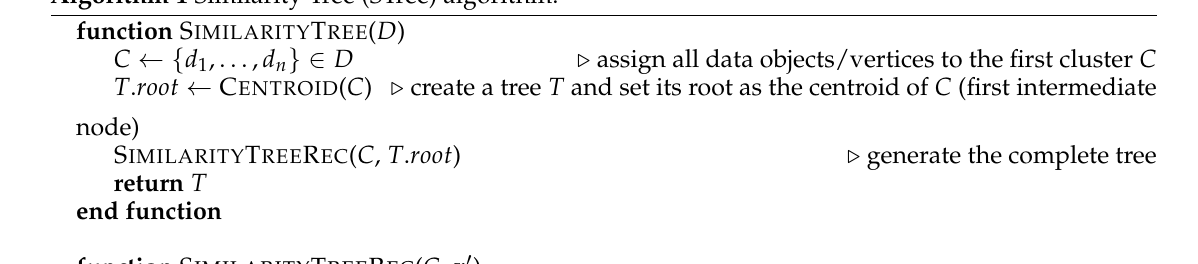
Algorithm 1 Similarity Tree (STree)